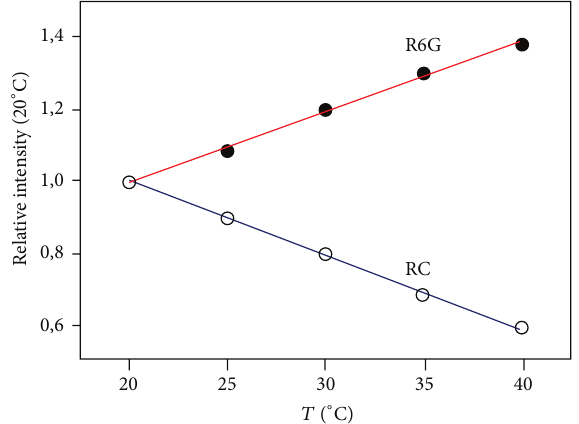
Figure 2: Temperature dependence of the relative fluorescence intensity of R6G and